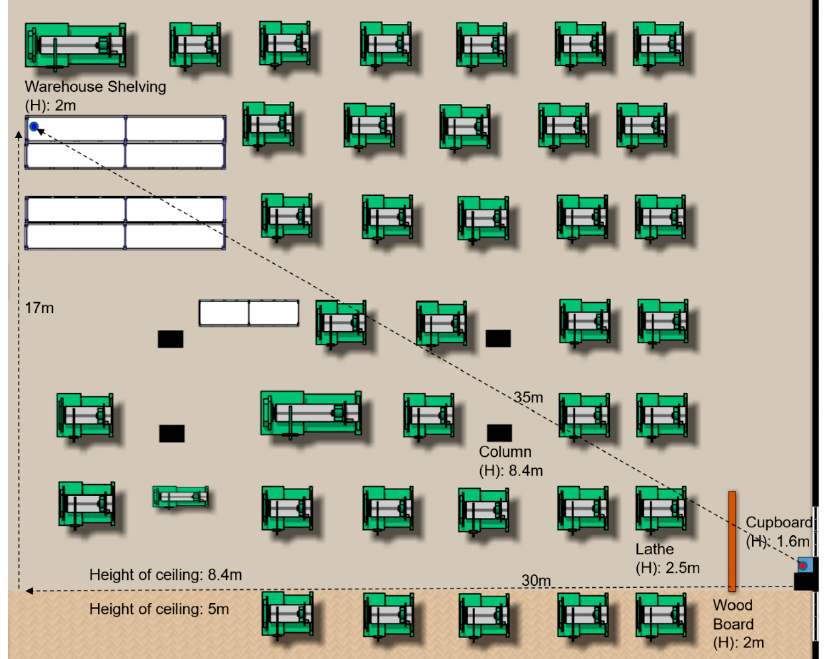
Figure 3. Layout of experimental environment.